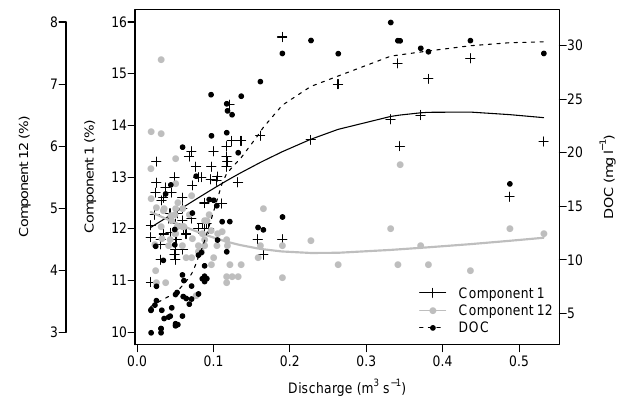
Fig. 5. Quality of DOC from different source compartments as re- vealed by fluorescence excitation-emission matrices and PARAFAC analysis.